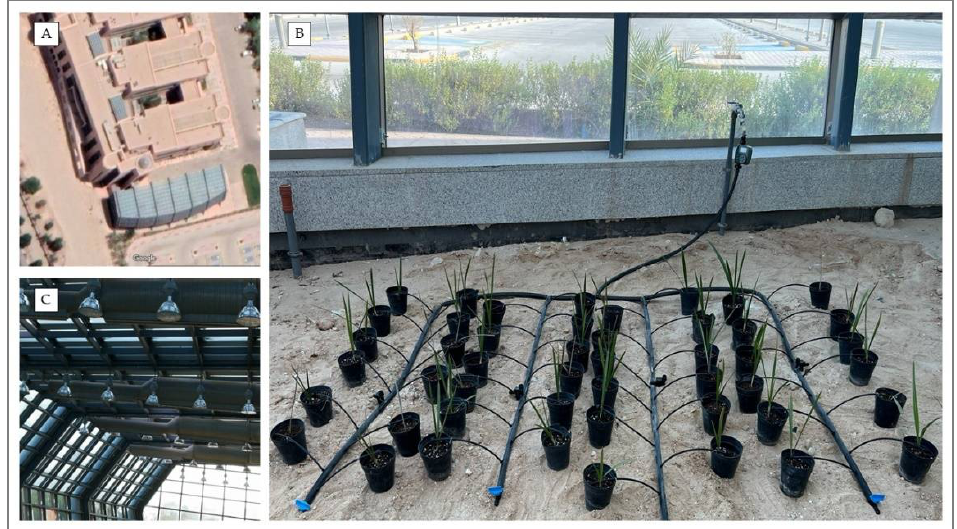
Figure 7. The experimental setup of TCPs for acclimatization in the TGAS. ( A ) Screenshot from Google of the glasshouse site, ( B ) The experimental setup, ( C ) Air conditioning and lighting systems in the glasshouse.